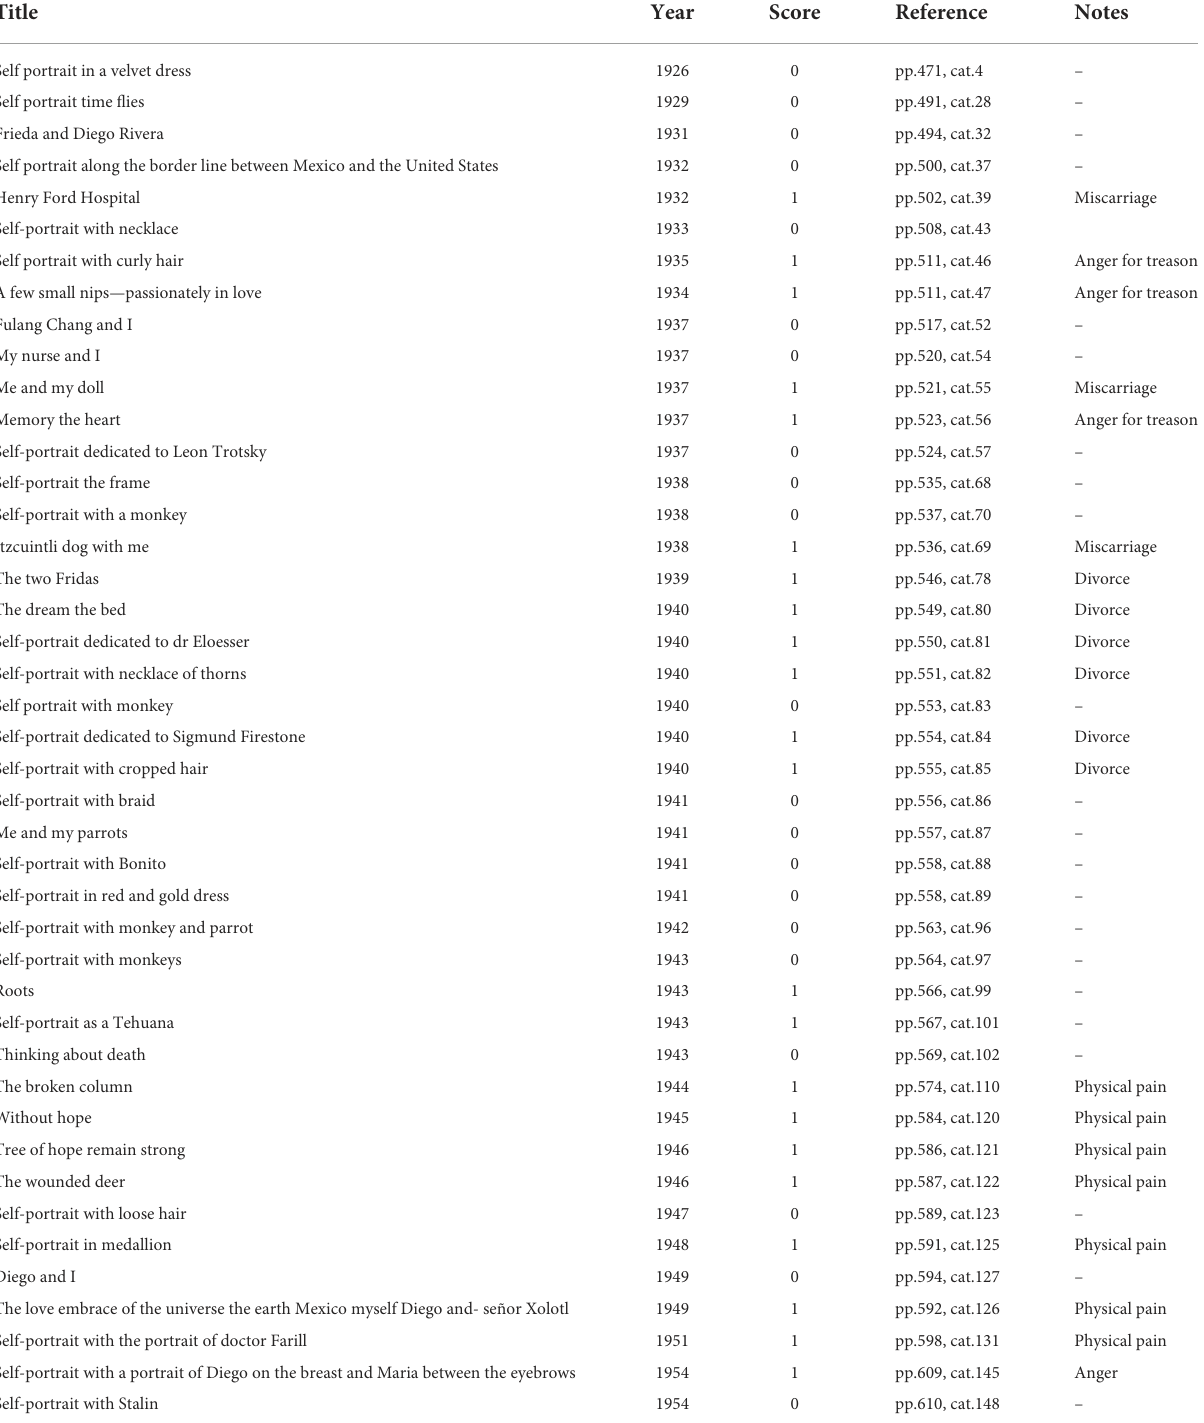
TABLE 1 The list of the self-portraits with corresponding year of production, pain/anger scores that were assigned based on the intent of the author to express pain or anger, the reference the scores were based upon [pages and catalog numbers as in Lozano et al. (2021)] and brief notes on what the pain score is based